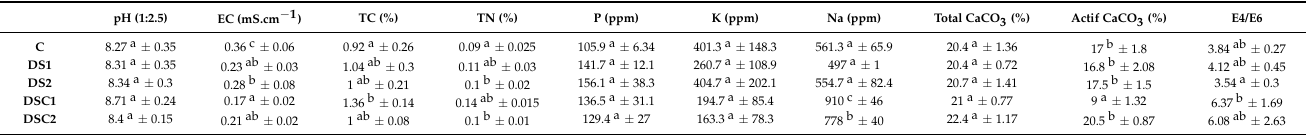
Table 2. Changes in soil chemical properties after the application of raw and compost de-inking paper sludge for two